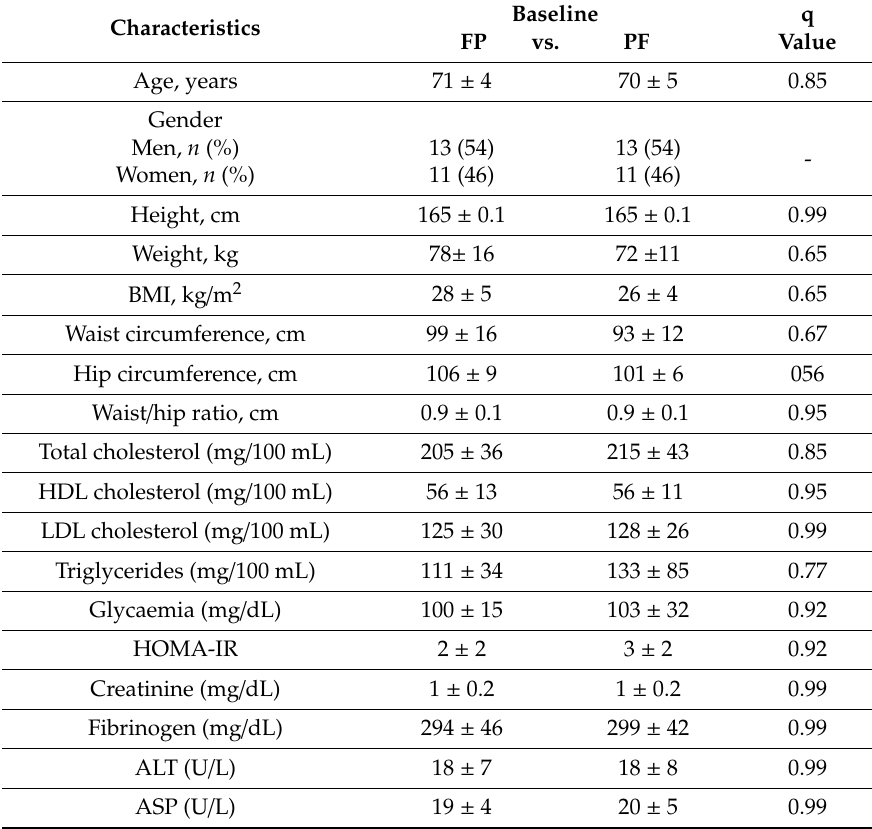
Table 3. Baseline characteristics of the study